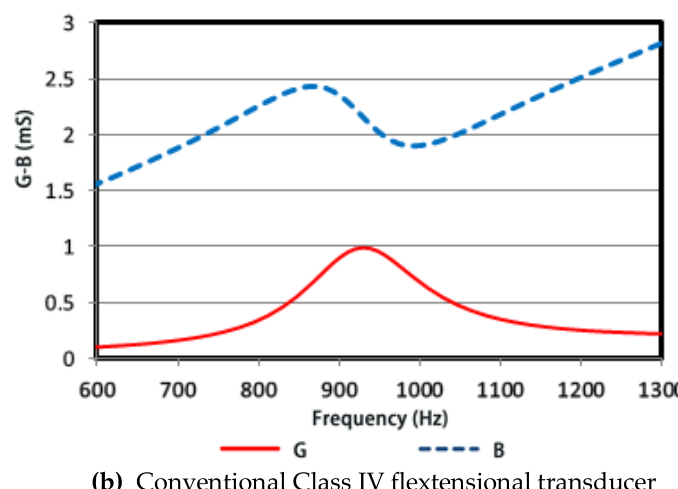
Figure 15. The admittance curves of two types of Class IV FT in water.